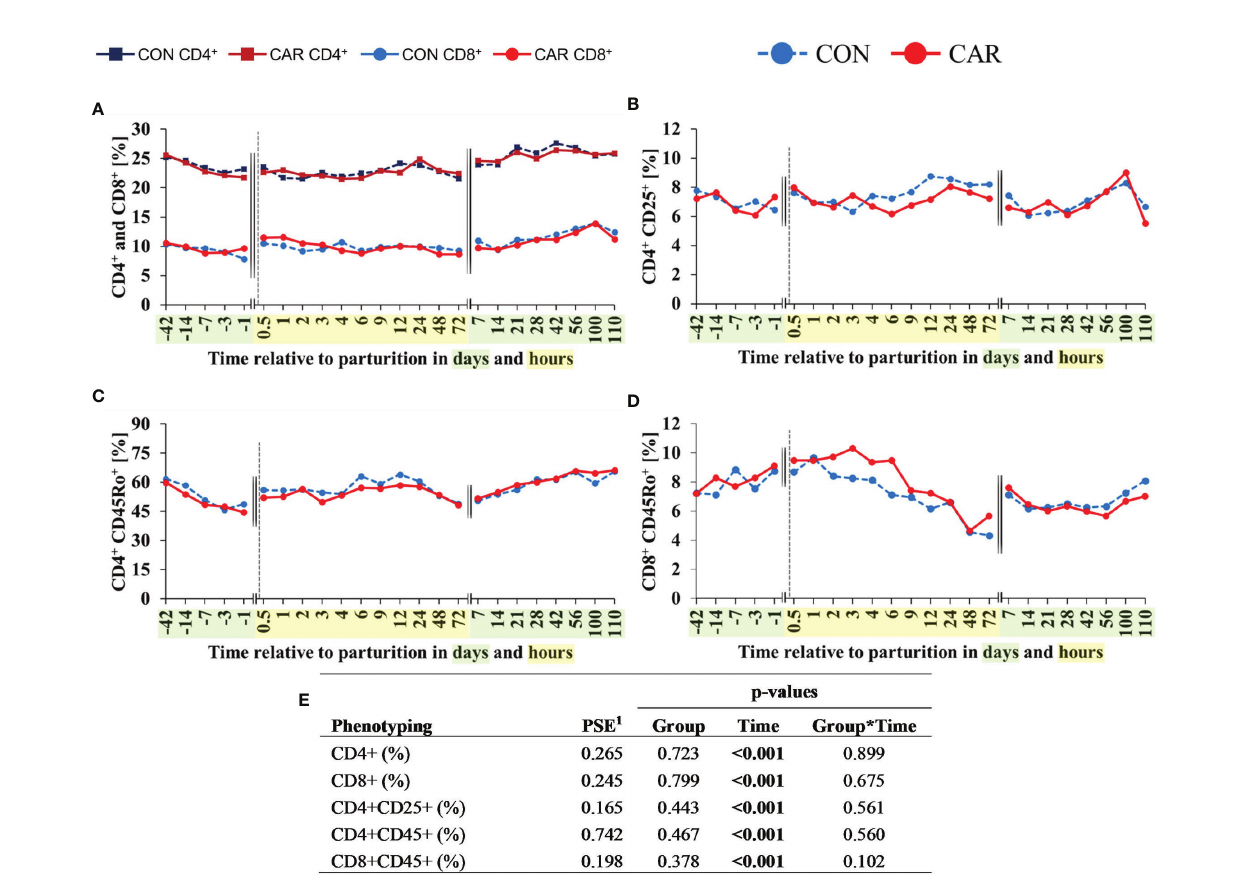
FIGURE 6 | Flow cytometric quanti fi cation of leukocyte subpopulations of dairy cows fed a diet supplemented with (CAR) or without (CON) L-carnitine from 6 weeks before until 15 weeks after parturition. (A) T-helper (CD4 + ) and cytotoxic T-cells (CD8 + ), (B) regulatory T-cells (Treg, CD4 + CD25 + ), (C) memory T-helper cells (CD4 + CD45Ro + ), and (D) memory cytotoxic T-cells (CD8 + CD45Ro + ) were expressed as percentages of total population of peripheral blood mononuclear cells (PBMC) identi fi ed by its relative size and granularity. (E) Data statistics. Data are shown as least square means. 1 pooled standard